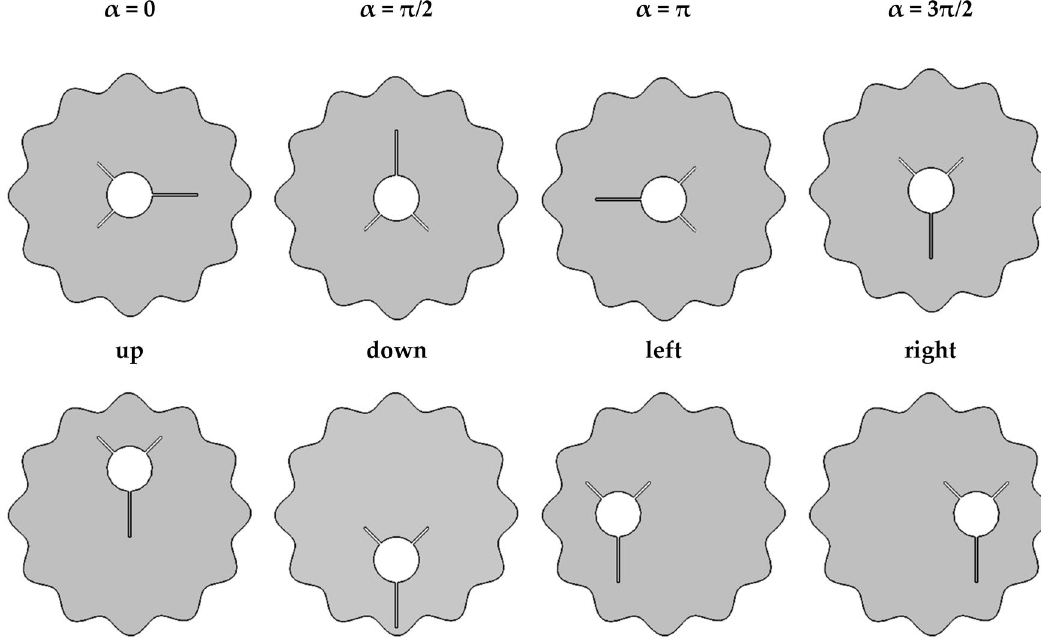
Figure 2. Different cases considered for orientation and positioning of the finned tube in this study.